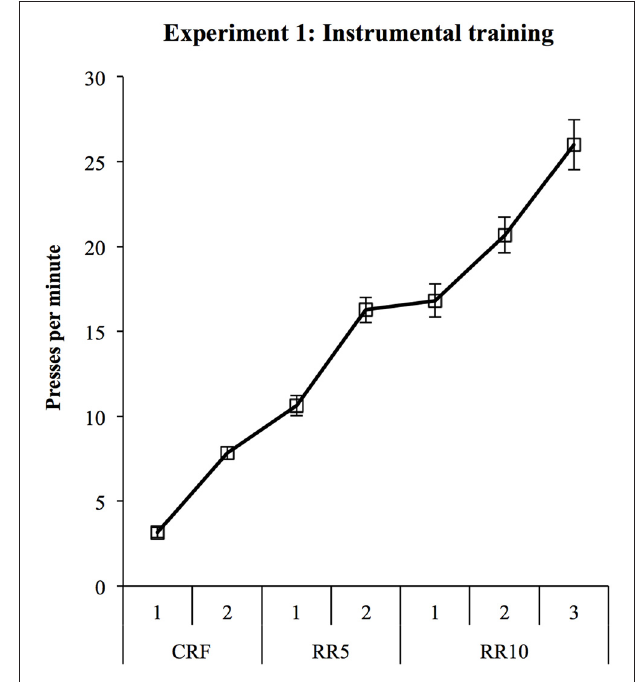
FIGURE 2 | Experiment 1 instrumental training. Rats were trained to make two lever presses for pellets and 20% sucrose